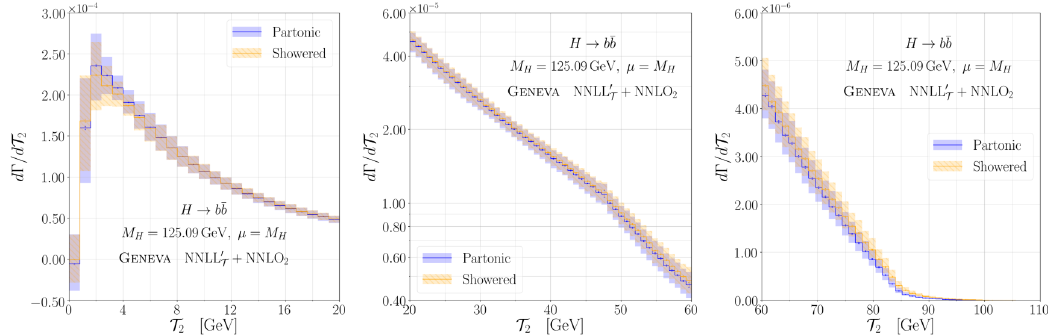
Figure 5. Validation of the T 2 spectrum in Geneva for H ! b (cid:22) b . The partonic NNLL 0 +NNLO T 2 resummation is compared to the showered results, before the addition of nonperturbative effects.